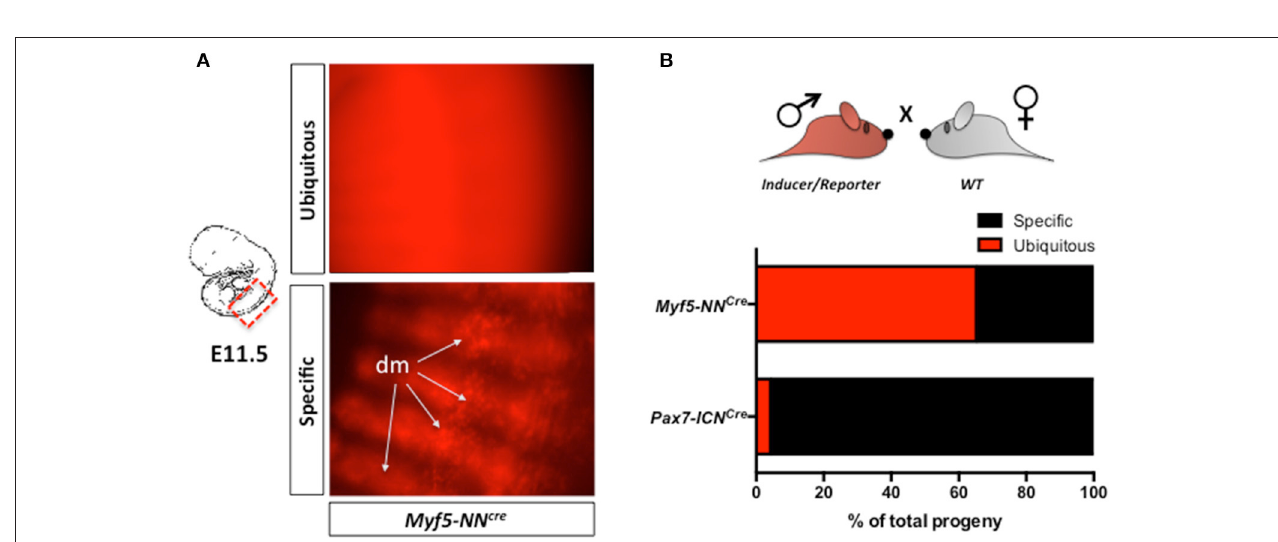
FIGURE 4 | Occasional ectopic Cre-mediated reporter expression in compound mutant. (A) Representative pictures of the trunk of Myf5-NN Cre ; Z/RED mut / wt E11.5 embryos presenting ubiquitous (upper) or muscle-specific (lower) fluorescence. In the latter case, DsRed.T3 + ve myotomes/dermomyotomes are easily identified at the microscope. (B) Quantification of the progeny characterized by muscle-specific or ubiquitous reporter gene expression after crossing double mutant males presenting both “inducer” (expression of Cre recombinase) and “reporter” (Cre-mediated permanent expression a reporter gene) features with WT females. Myf5-NN Cre and Pax7-ICN Cre inducer lines are compared to each